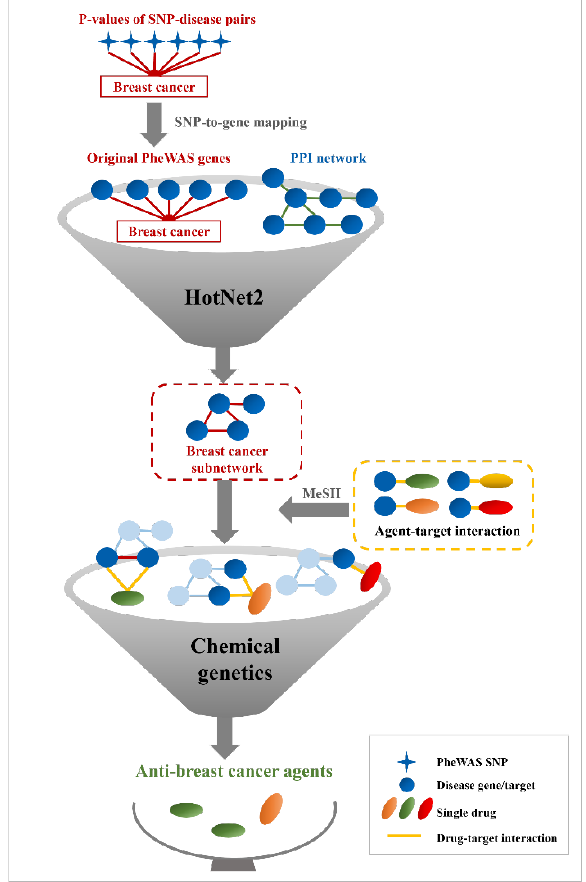
Figure 1. Pipeline of HotNet2-based anti-breast cancer drug discovery. A total of 522 breast cancer-associated single nucleotide polymorphisms (SNPs) were derived from the phenome-wide association study (PheWAS) [9]. The strongly linked variants of these SNPs were obtained by linkage disequilibrium (LD) analysis on the basis of the 1000 Genomes Project (r 2 ≥ 0.8). Then, the genes potentially regulated by the PheWAS-derived loci were identified through the combinatorial application of various information, such as physical proximity to the gene, gene expression quantitative trait loci (eQTL), and the locations of variants overlapped with DNase I-hypersensitive site (DHS) peaks. Finally, a total of 1742 breast cancer-associated genes were identified from the PheWAS data. After HotNet2 calculation, significant subnetworks including 227 genes were successfully identified from the original PheWAS data. Finally, these agents that target HotNet2-derived pathogenic genes were predicted to be potential anti-breast cancer drugs. PPI: protein–protein interaction. MeSH: Medical Subject Headings.